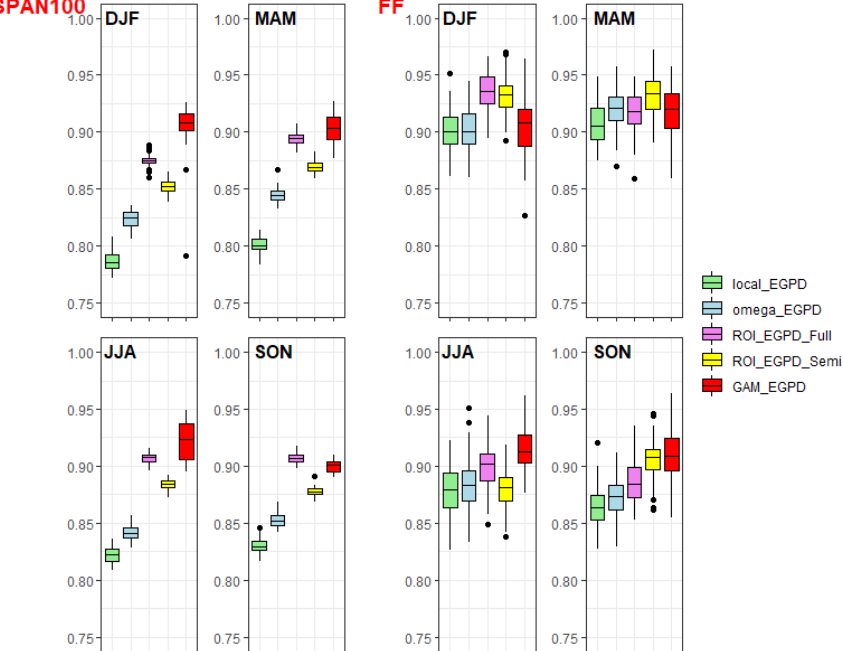
Figure 5. Criteria applied to the upper tail for each season. Left: robustness of the local EGPD and the four candidate models, as measured by the SPAN criteria. The stability is measured with respect to a 100-year return-level estimate. Each box plot contains 50 values. Right: reliability in prediction of the maxima as measured by the FF criteria; each box plot contains 100